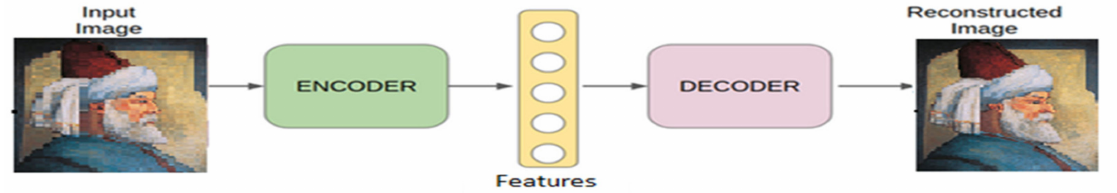
Figure 1. Framework of proposed model.